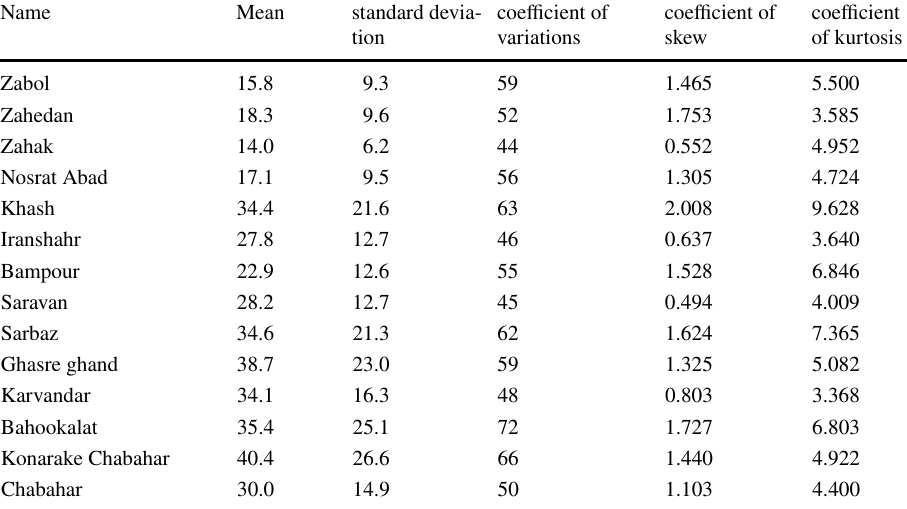
Table 2 Basic statistics of the annual extreme daily rainfall data of the